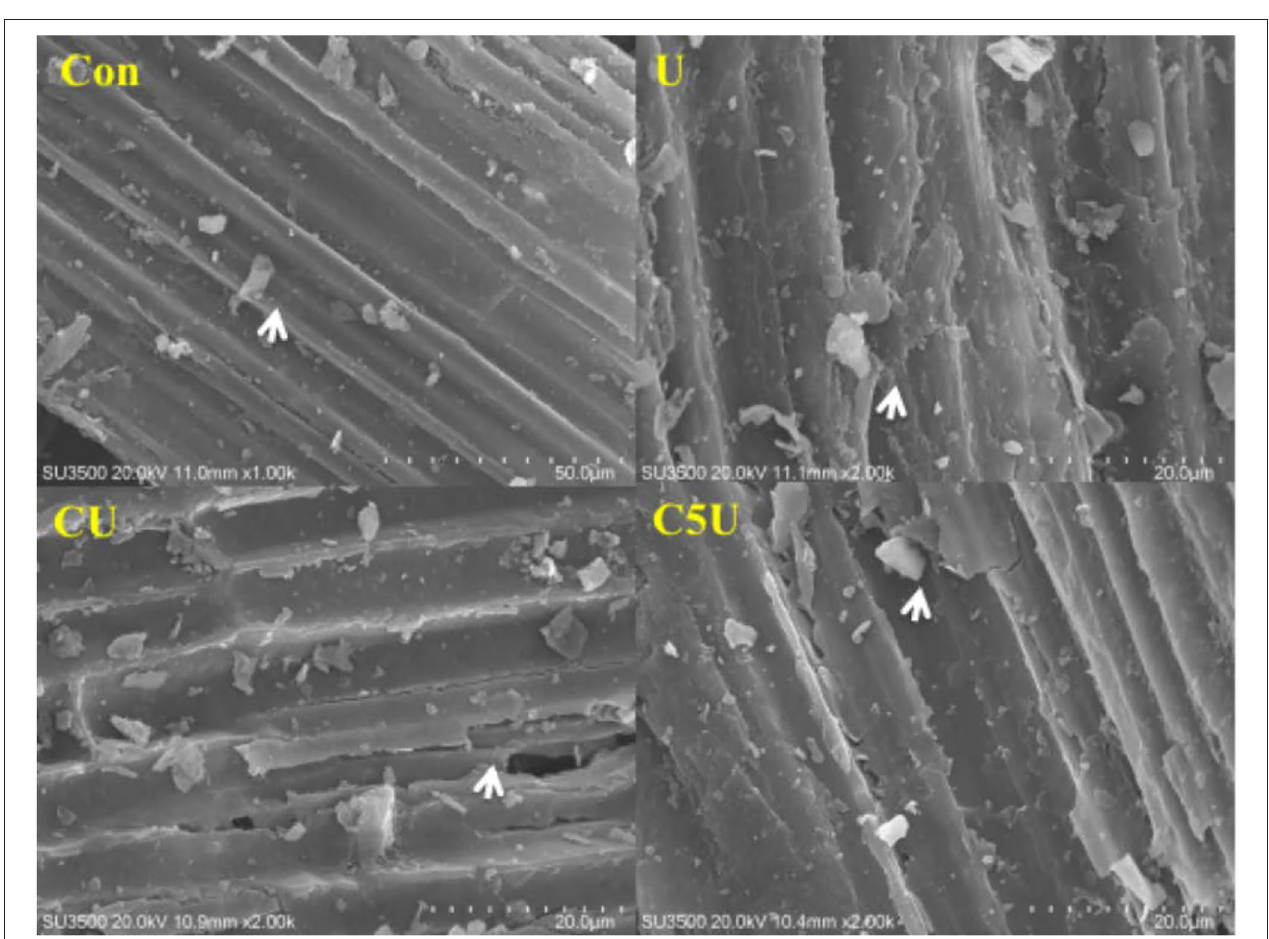
FIGURE 1 | Scanning electron microscopy (SEM) images of biomass residues obtained from pre-treatment with corn steep liquor (CSL) and urea. Con, without additive control; U, 5% urea; CU, 9% CSL + 2.5% urea; C5U, 9% CSL + 5% urea. Sample (U, CU, and C5U) showing a coarse surface indicated as an arrow, and sample Con displaying a flat